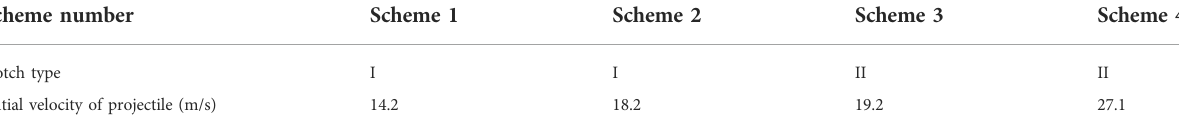
TABLE 2 The details of simulation